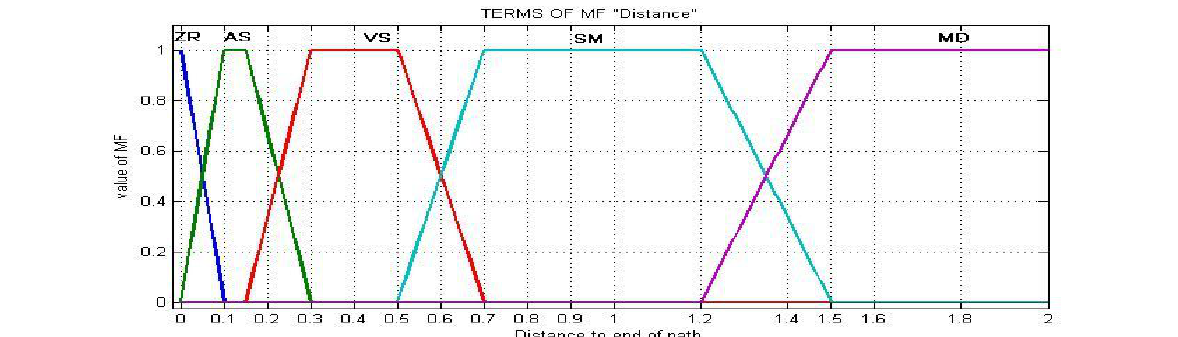
Figure 4. Term-sets ZR, AS, VS, SM, MD of linguistic variable «Distance»